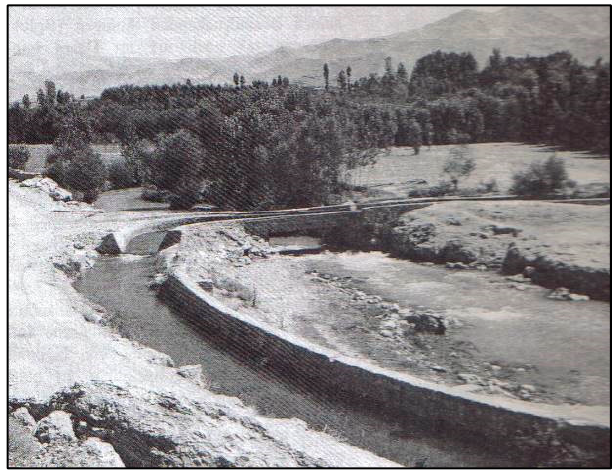
Figure 12. View of ruins from Menua canal [97], which still conveys water from Lake Ke ş i ş [94].